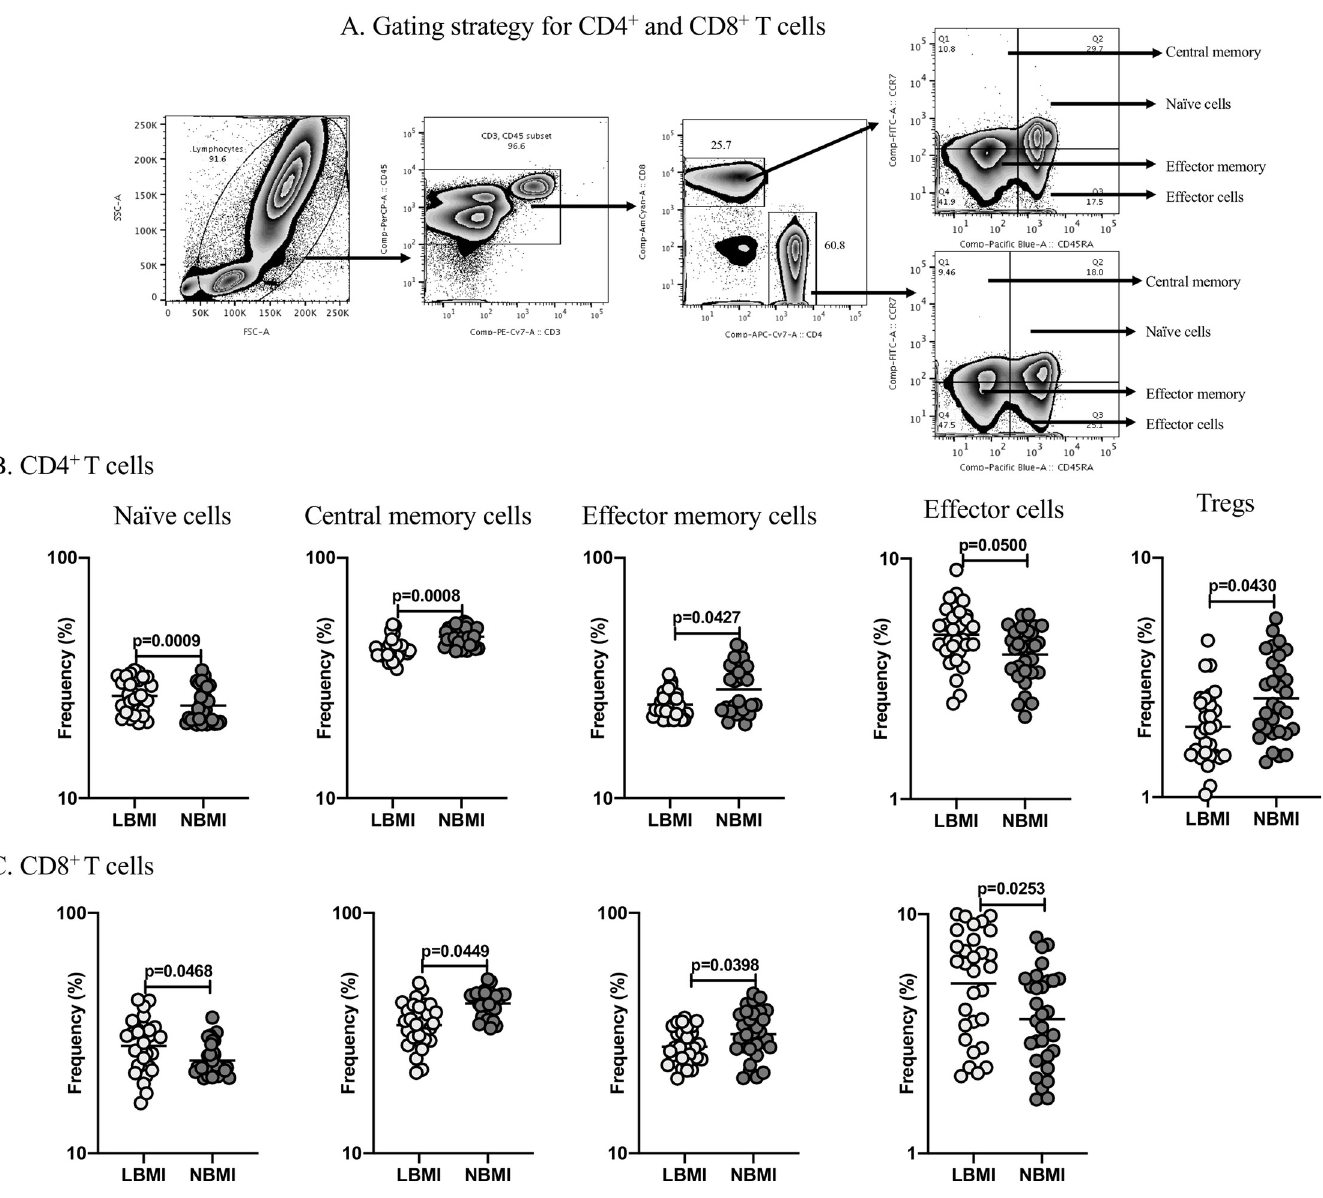
Fig 2. LBMI is associated with altered frequencies of CD4 + T cells and CD8 + T cells. ( A) Gating strategy for CD4 + T cells and CD8 + T cells: An illustrative flow cytometry plot from a LTBI-LBMI individual depicting the gating strategy for na ï ve, central memory and effector memory cells from CD4 + and CD8 + T cells. Na ï ve cells were defined by the expression of CD45RA + CCR7 + ; effector memory cells as CD45RA - CCR7 - ; central memory cells as CD45RA - CCR7 + ; and effector cells as CD45RA + CCR7 - . (B) The frequencies of CD4 + T cell subsets—na ï ve cells, central memory, effector memory cells, effector cells and regulatory T cells in LTBI-LBMI [LBMI] (n = 30) or LTBI-NBMI [NBMI] (n = 30) group. (C) The frequencies of CD8 + T cell subsets—na ï ve cells, central memory, effector memory cells, effector